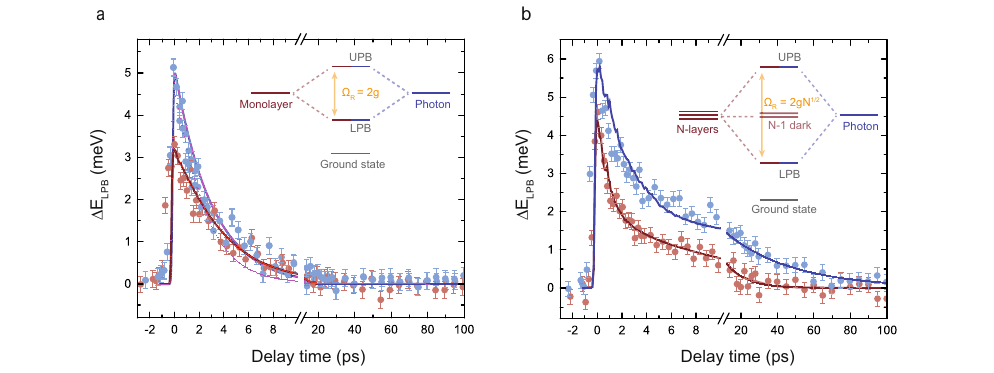
N3.TheLPBblueshiftasafunctionofthetimedelaycanbewellapproximatedbya two-exponential decay. The polariton eigenstates in the superlattice-N3